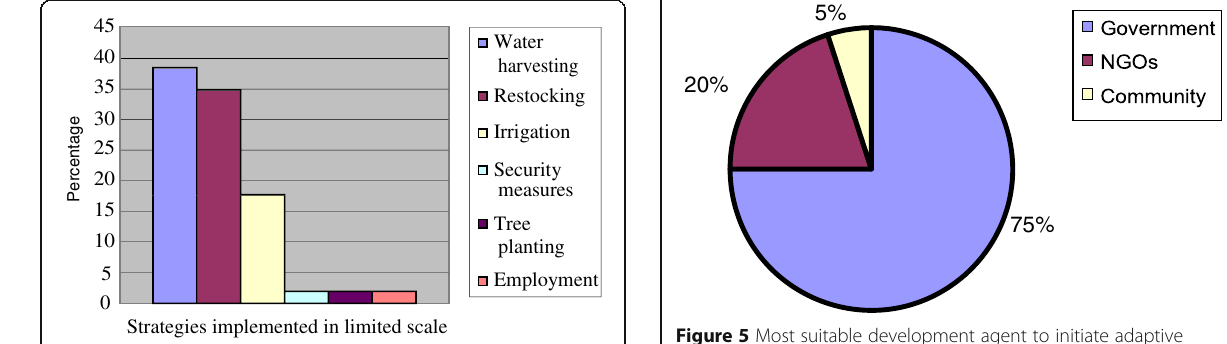
Figure 4 Adaptive strategies not implemented on a large scale